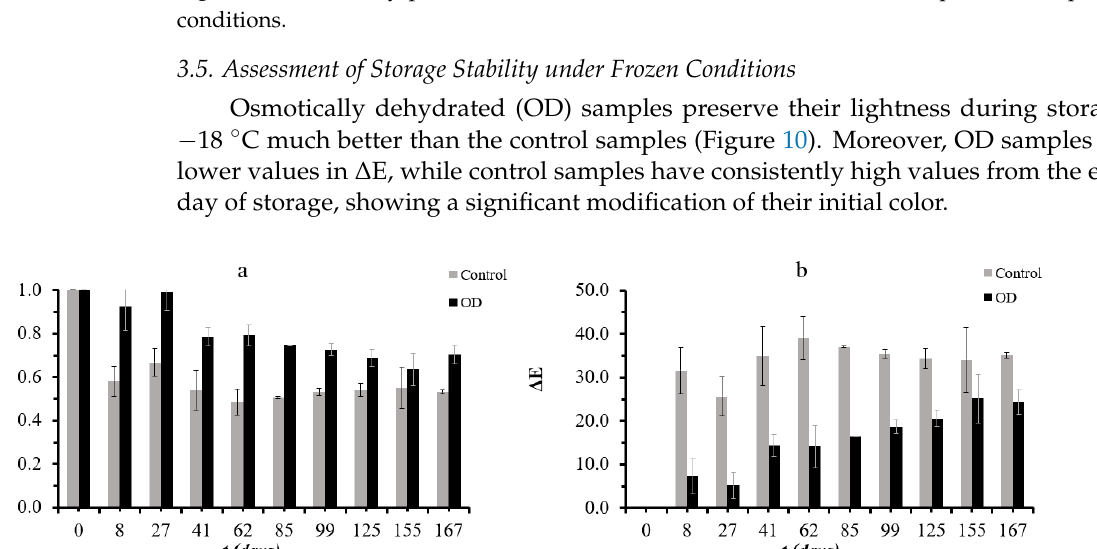
Figure 9. Desirability plot of variables and illustration of mushroom samples at the optimized conditions.